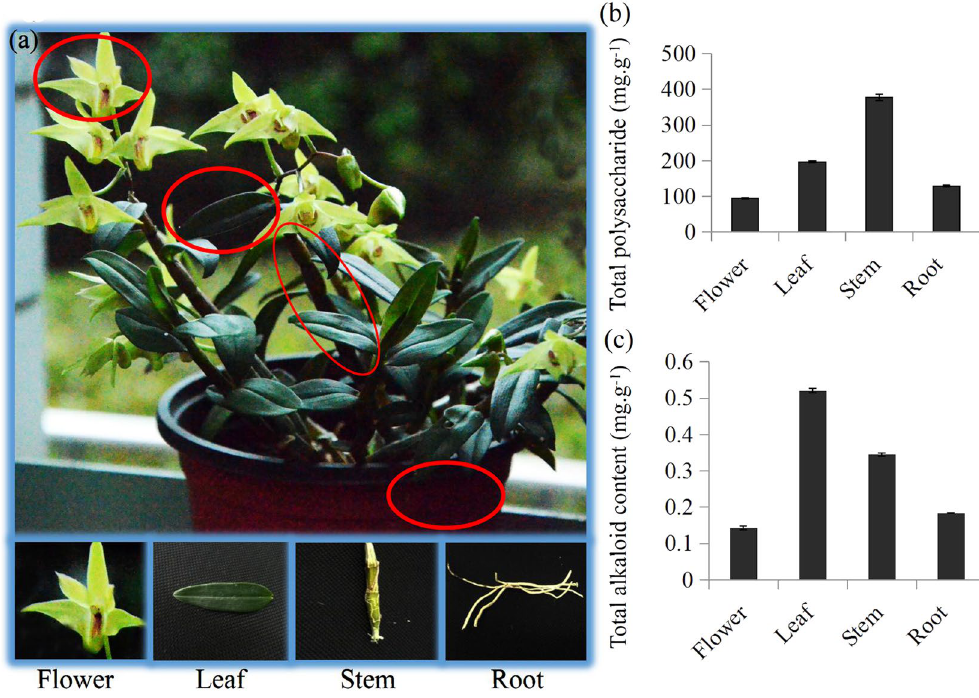
Figure 1. Determination of polysaccharide and alkaloid contents in four different organs of D. officinale L. ( a ) Samples from different organs of D. officinale L. ( b ) Determination of polysaccharide contents in four organs, including flower, leaf, stem and root, of D. officinale L. ( c ) Determination of alkaloid contents in four organs, including flower, leaf, stem and root, of D. officinale